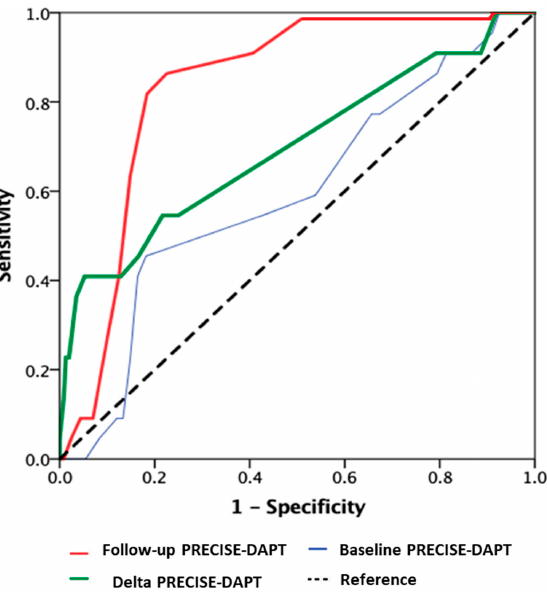
Figure 3. Area under the curve in predicting bleeding in baseline, follow-up and delta PRECISE-DAPT scores, as assessed in patients receiving DAPT included in the RESCORE multicenter pro-